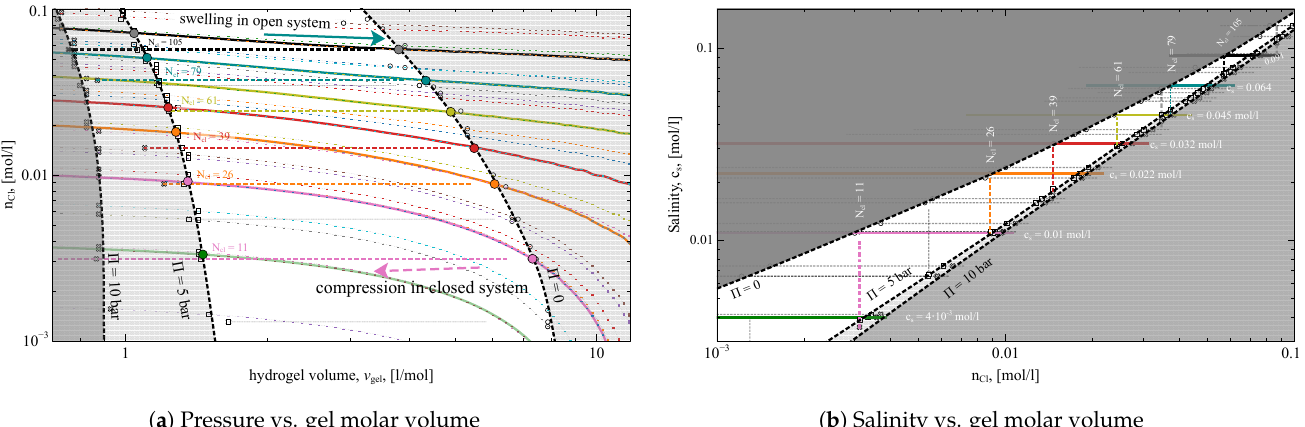
Figure 3. The compression of the gel in open system (solid lines) and in closed system (dotted lines). Shadowed area limit the states with applied pressure below zero and above 5 bar. The values N Cl − are the virtual numbers of present Cl − ions in closed system simulation